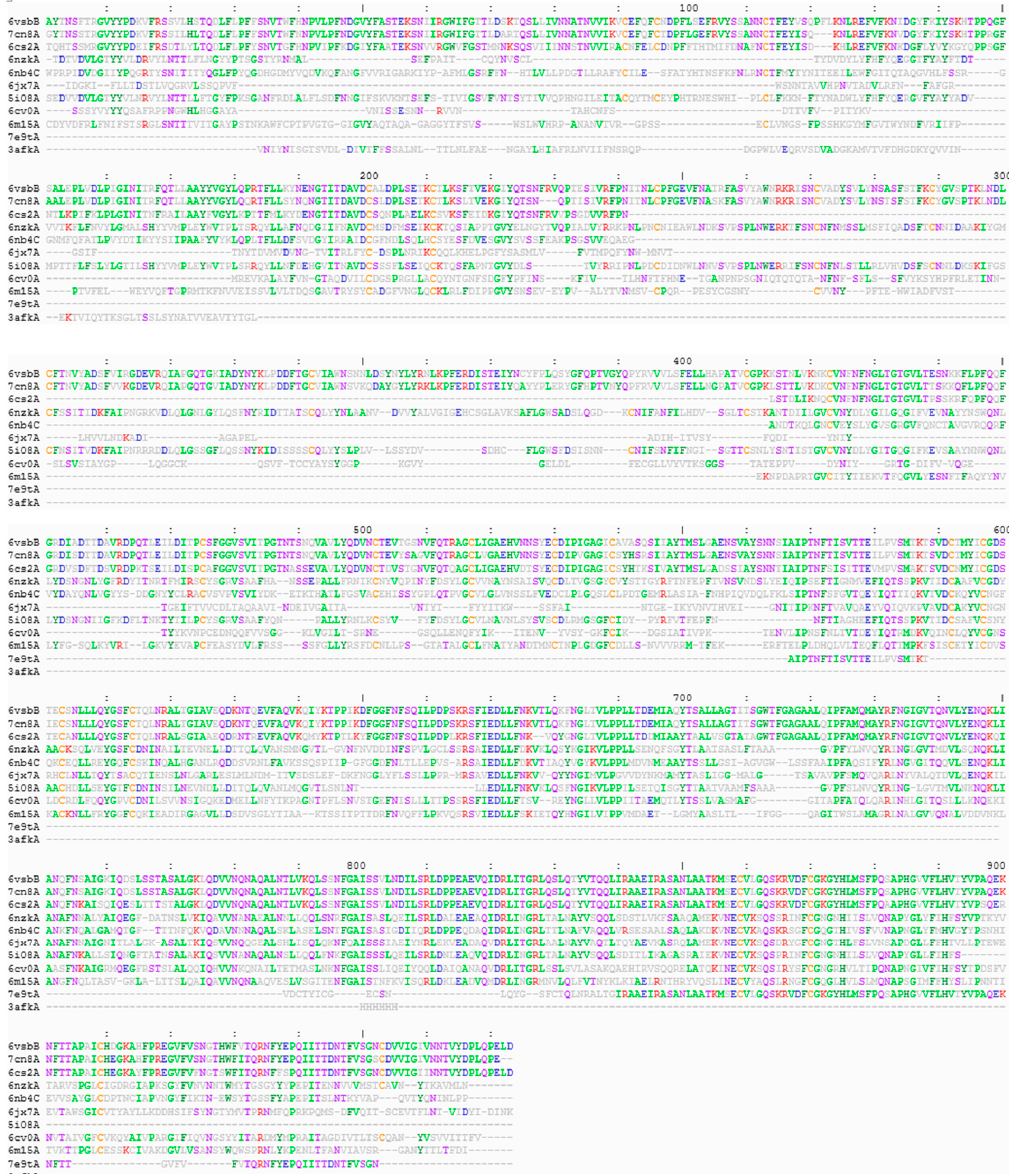
Figure 2. Structural alignment of AAs in 10 protein structures against the query structure. The most frequent AA type in each column is colored. For example, purple residues (S, T, N and Q) are uncharged, brown residues (R and K) are polar positively charged, blue residues (D and E) are polar negatively charged, dark green residues (F, Y, W and H) are non-polar except histidine (positive) but they are aromatic, light green residues (A, V, I and L) are non-polar residues and yellow residue (C) is a special case. The uppercase letters that are bold show conserved structurally equivalent positions with the query structure and non-color regions are variable